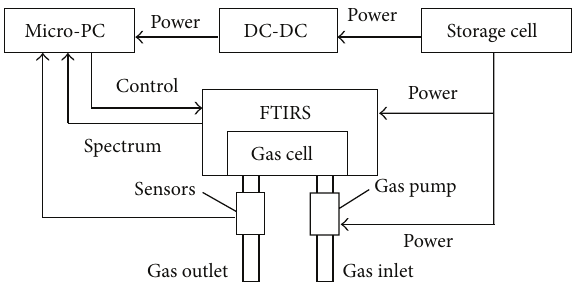
Figure 1: Schematic diagram of the portable gas analyzer based on an FT-IR spectrometer. The storage cell provides power for FT-IR spectrometer, gas pump, and micro-PC. The gas pump is used to pump the analyzed gas into gas cell. Sensors include temperature andpressure.Theyareusedtomonitorthetemperatureandpressure of analytes for compensating the effects of gas temperature and pressure on gas concentration. A micro-PC reads the absorption spectrum of analyte and performs the spectrum analysis.